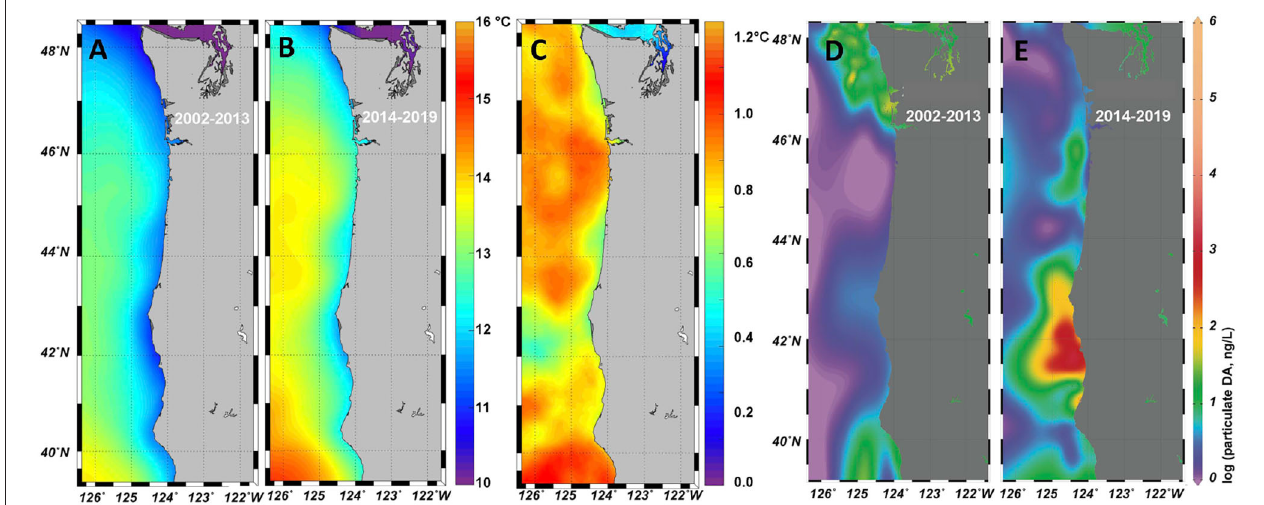
FIGURE 1 | Sea surface temperature from the Multi-scale Ultra-High Resolution Sea Surface Temperature (MURSST) monthly product for September–November is shown for 2002–2013 (A) and 2014–2019 (B) . The difference (B–A) is shown in panel (C) . A large dataset of particulate domoic acid (pDA), collated from multiple programs along the US west coast, includes shore-based observations. Data from 2002–2013 (D) and 2014–2019 (E) were spatially interpolated using DIVA in OceanDataView. The northern California region of enhanced toxicity is prominent in the 2014–2019 dataset, and consistent with the expected optimal temperature for DA production (Ryan et al., 2017; Kudela et al., 2020).